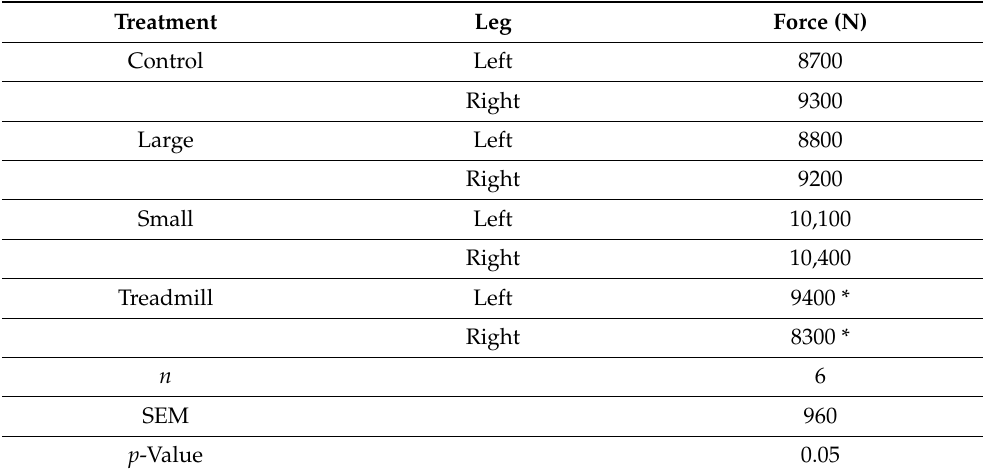
Table 7. Fracture force of calf MC III and IV by treatment and leg.